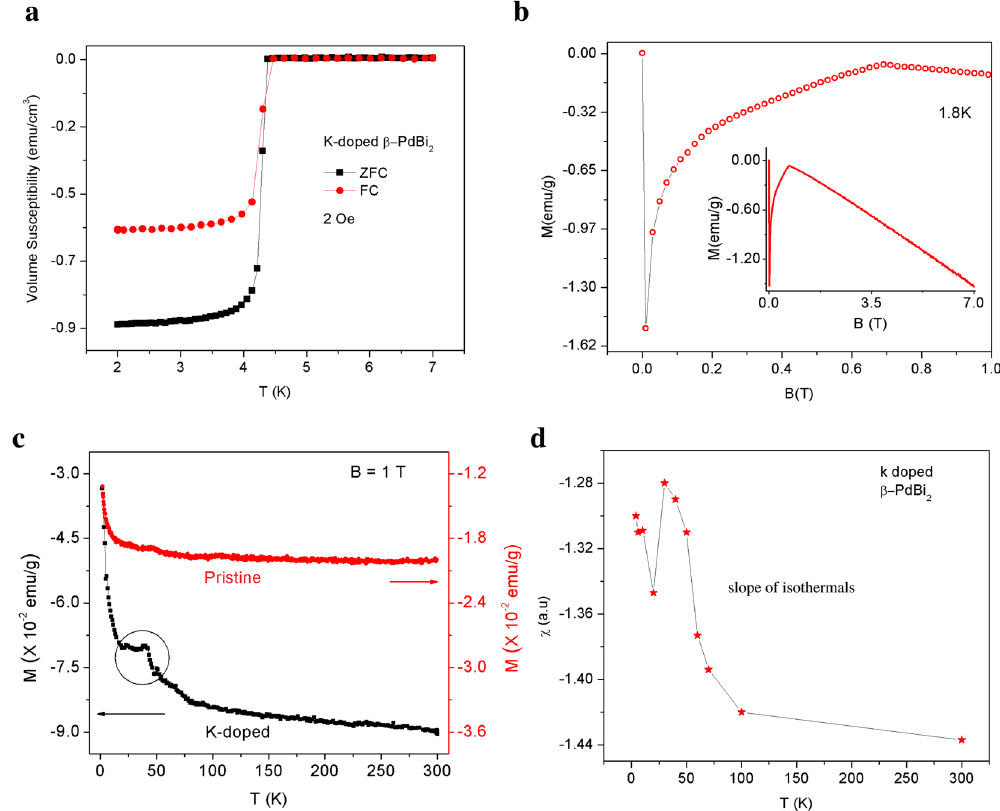
Figure 1. Basic transport properties of K-doped β -PdBi 2 . ( a ) Meissner effect in K-doped β -PdBi 2 . Zero-field- cooled (ZFC) data reveals bulk superconductivity onset at 4.4 K. ( b ) Magnetization as a function of applied magnetic field ( M - B ): plot suggests the upper critical field at 1.8 K is 0.68T. The inset shows that the non- superconducting state is diamagnetic. ( c ) Magnetization of K-doped β -PdBi 2 in the non-superconducting state, showing a hump around 30 K. Such feature is characteristic of spontaneous spin ordering. ( d ) Theintrinsic magnetic susceptibility χ = M / B is calculated from the slope of the plots of isotherms of the magnetization vs magnetic field at several temperatures. The results reveal that the magnetic ordering arising close to low temperatures is intrinsic to the